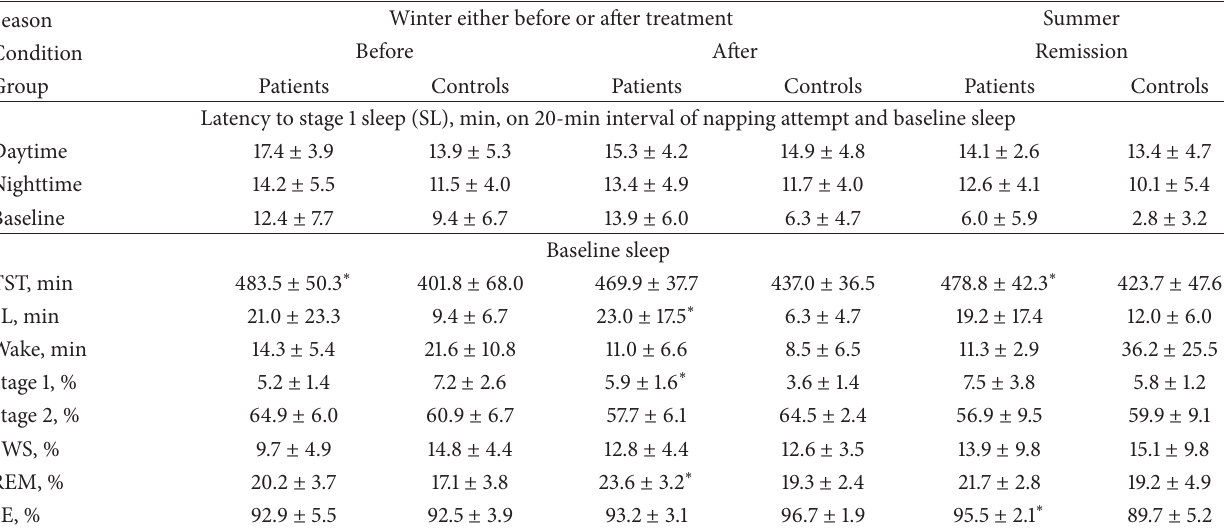
Table 2: Results of 𝑡 -test aimed on comparison of objective measures of sleepiness and